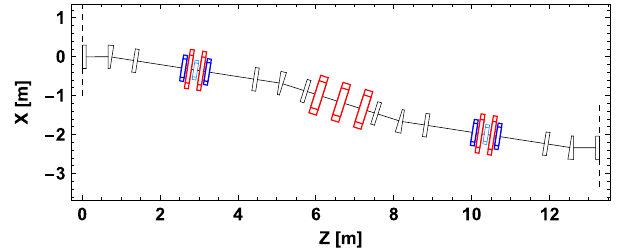
FIG. 12. Additional bends layout. Dipoles in black, quadru- poles in red, sextupoles in blue and octupoles in light blue.